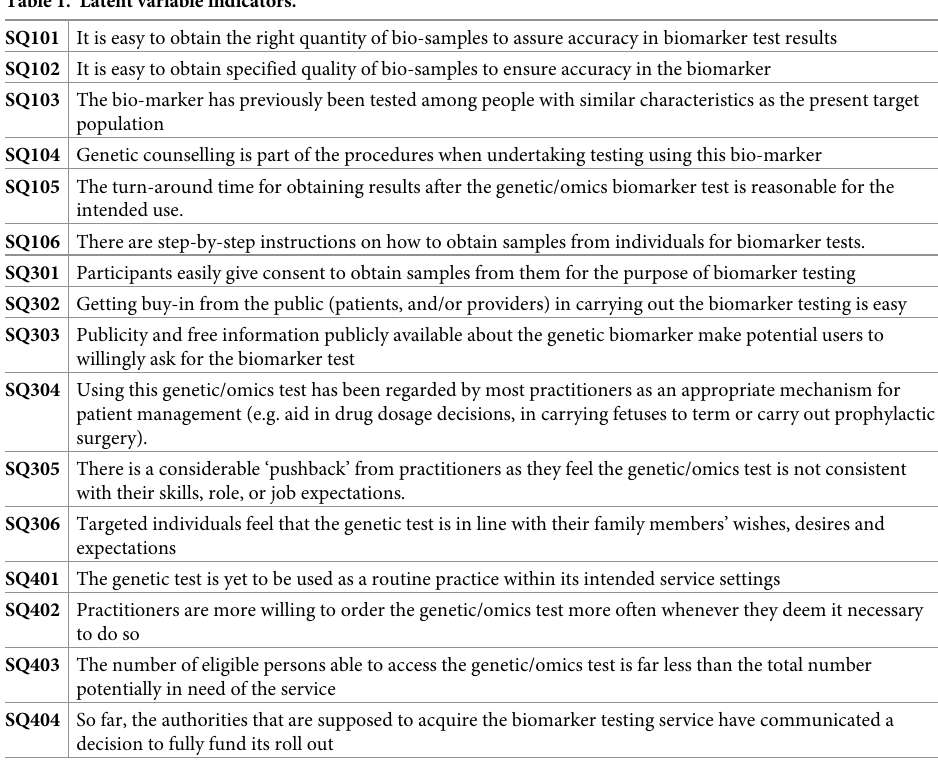
listed in Table 1. Indicators SQ101 to SQ106 for the exogenous variable “OBM” and